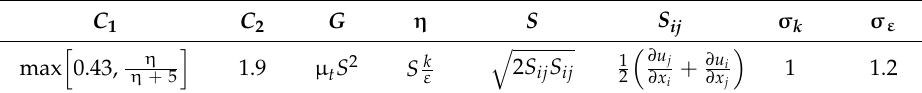
Table 6. Variables and constants appearing in turbulence equations